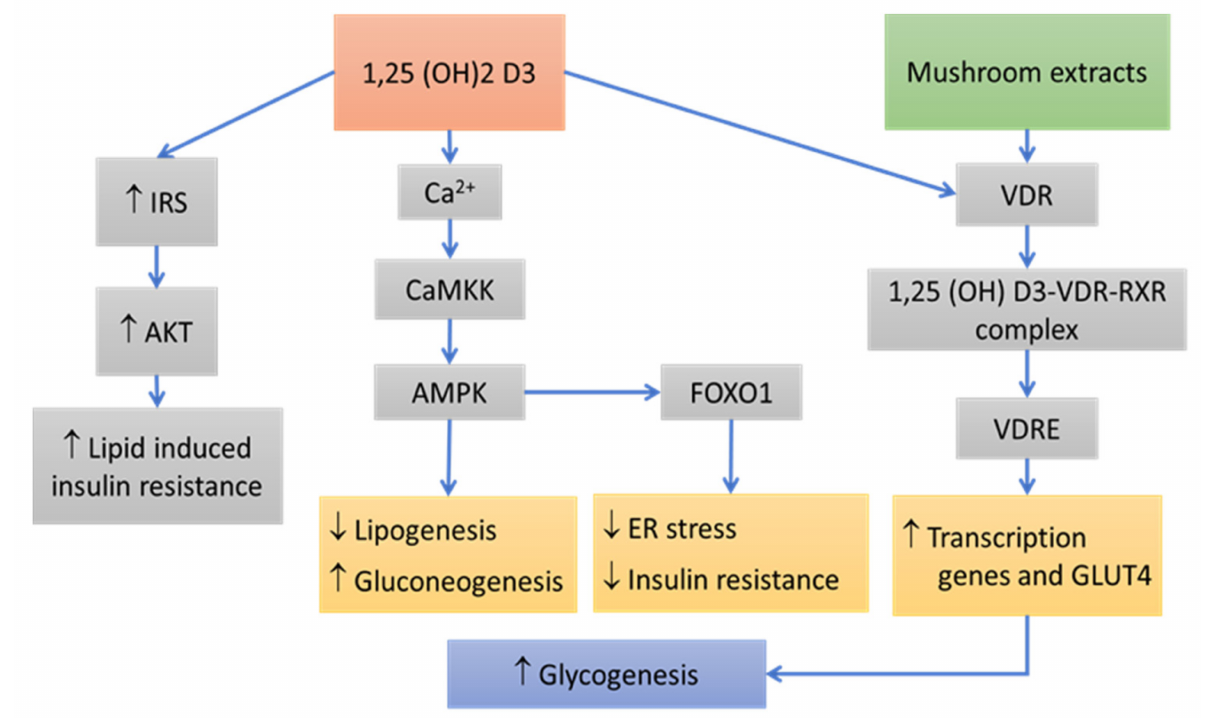
Figure 4. Relationship between vitamin D, mushroom extracts, and insulin resistance. IRS—insulin receptor substrate, AKT—protein kinase B, CaMKK—calcium/calmodulin-dependent protein kinase, AMPK—activated protein kinase, FOXO1—forkhead box transcription factor 1, VDR-, VDRE— vitamin D-responsive